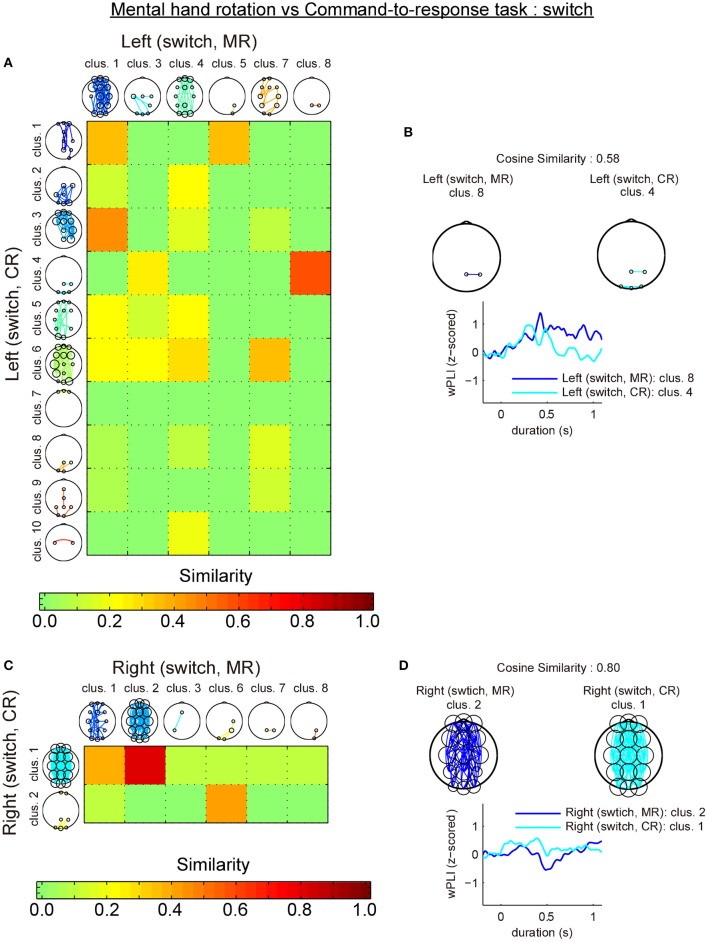
Comparison of the cluster-by-cluster similarity of the connectivity patterns (switch trials; mental hand rotation task vs. command-to-response task). (A) A matrix indicating the cluster-by-cluster similarity between the mental hand rotation and command-to-response task for the left condition in the switch trials. (B) Pairs of most similar clusters between the two tasks for the left conditions in the switch trials and comparison of the temporal responses. (C,D) These also show the results of the cluster-by-cluster similarity analysis of the connectivity patterns between the two tasks for the right condition in the switch trials. MR and CR indicate the mental hand rotation and command-to-response task, respectively.